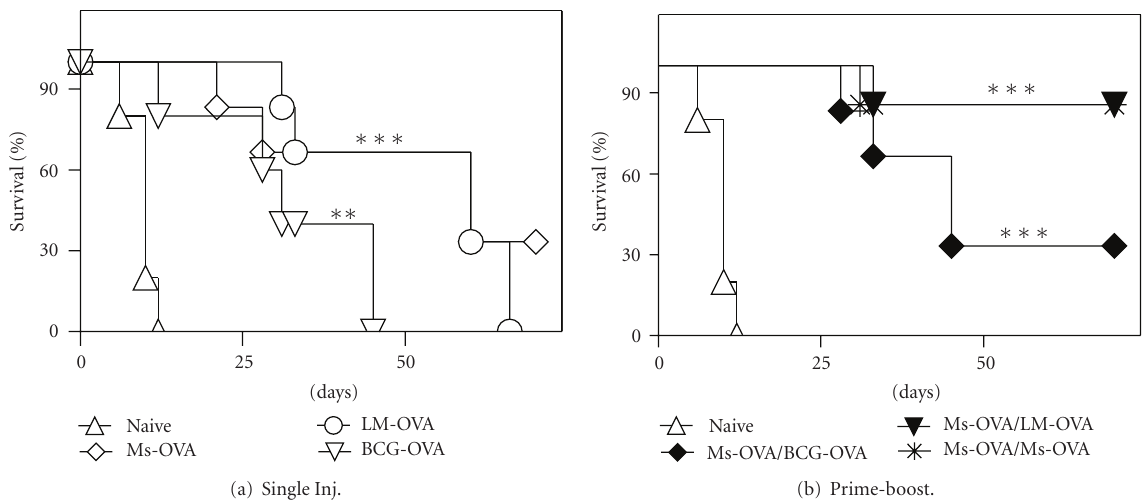
Figure 2: Tumor protection following heterologous prime-boost vaccination. C57BL/6J mice were vaccinated subcutaneously with a single dose of Ms-OVA (20 μ g OVA, 38 μ g/mg lipid loading, 94.1 nm average archaeosome size), LM-OVA (10 4 CFU), or BCG-OVA (10 4 CFU) or with a prime-boost regimen as indicated. Mice were challenged with subcutaneous B16-OVA tumors 4 weeks post vaccination. Survival plots are based on euthanizing animals upon reaching a maximum tumor size of 300 mm 2 ( n = 5/group). Survival curves for vaccinated groups were significantly di ff erent from na¨ıve group by log-rank test ( ∗∗ P < . 01, ∗∗∗ P < .